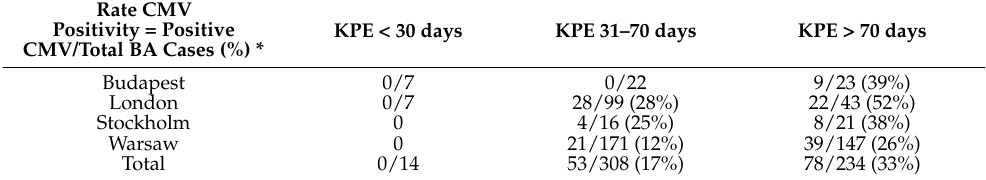
Table 2. Rate of CMV positivity in tested patients in relation to age at Kasai portoenterostomy (KPE). Rate CMV Positivity = Positive